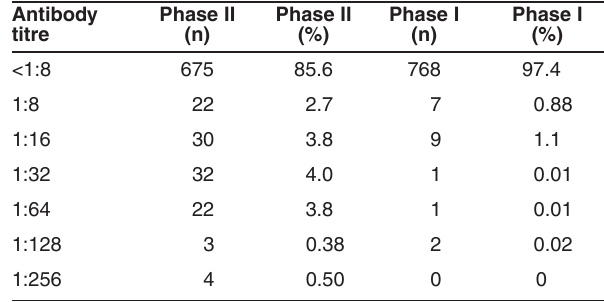
TABLE 1 Number and percentage of patients from each province who were seropositive for Coxiella burnetii , and the number who had Q fever Number Percentage